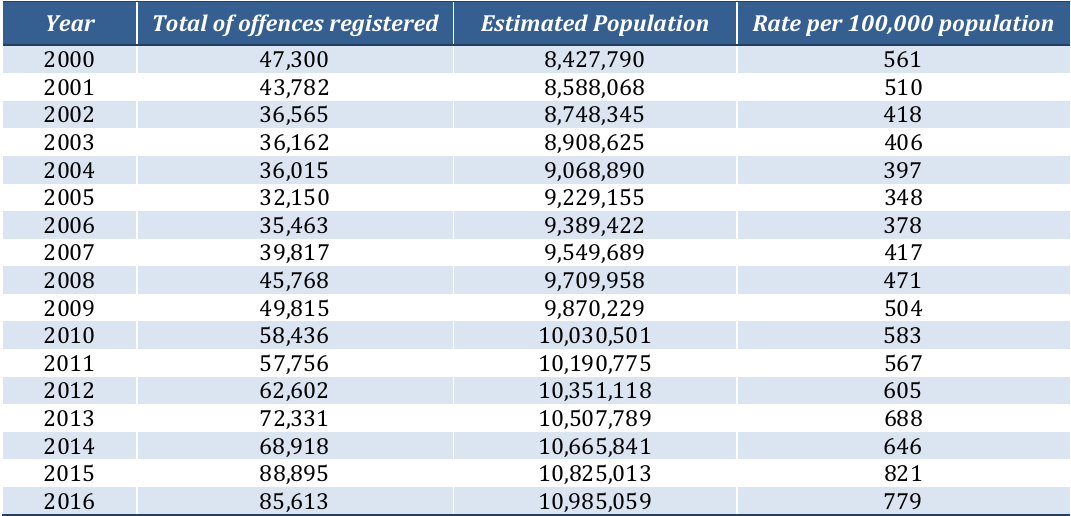
Table 1: General criminality registered by the Bolivian Police (2000 ‐